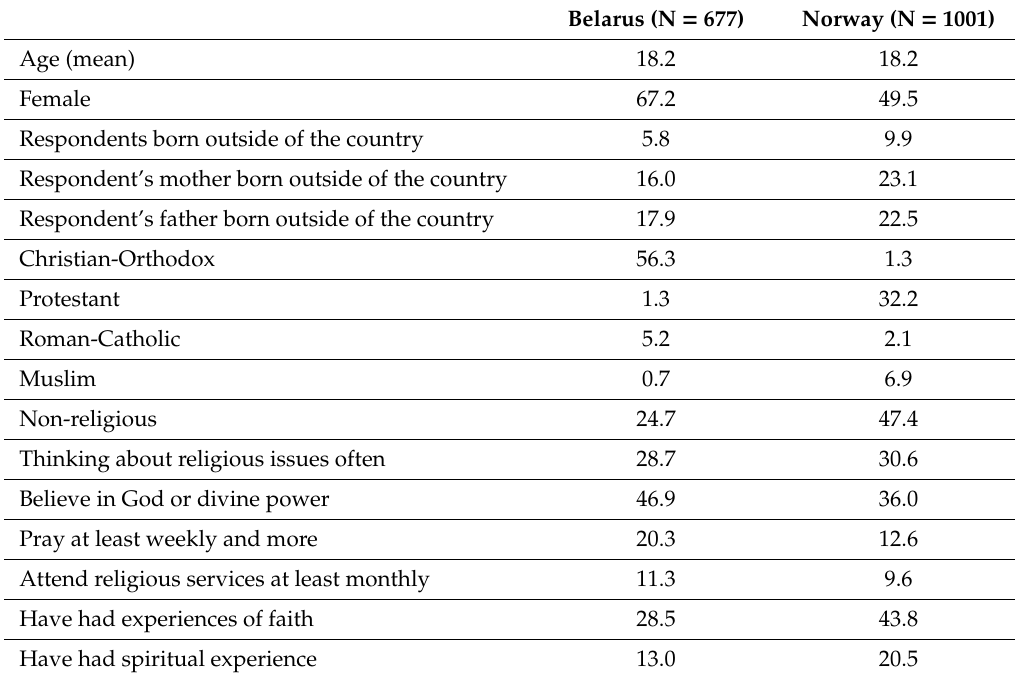
Table 1. Sample characteristics, Belarus and Norway (frequencies (%), except